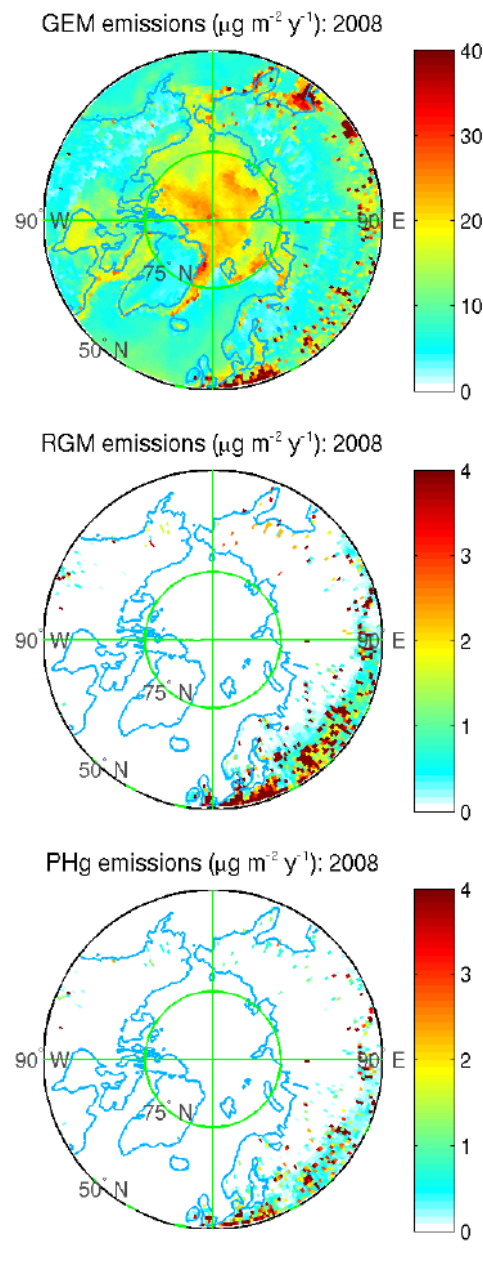
Fig. 6. Northern hemisphere high-latitude mercury emissions for 2008, as seen by Environment Canada’s Global/Regional Atmo- spheric Heavy Metals